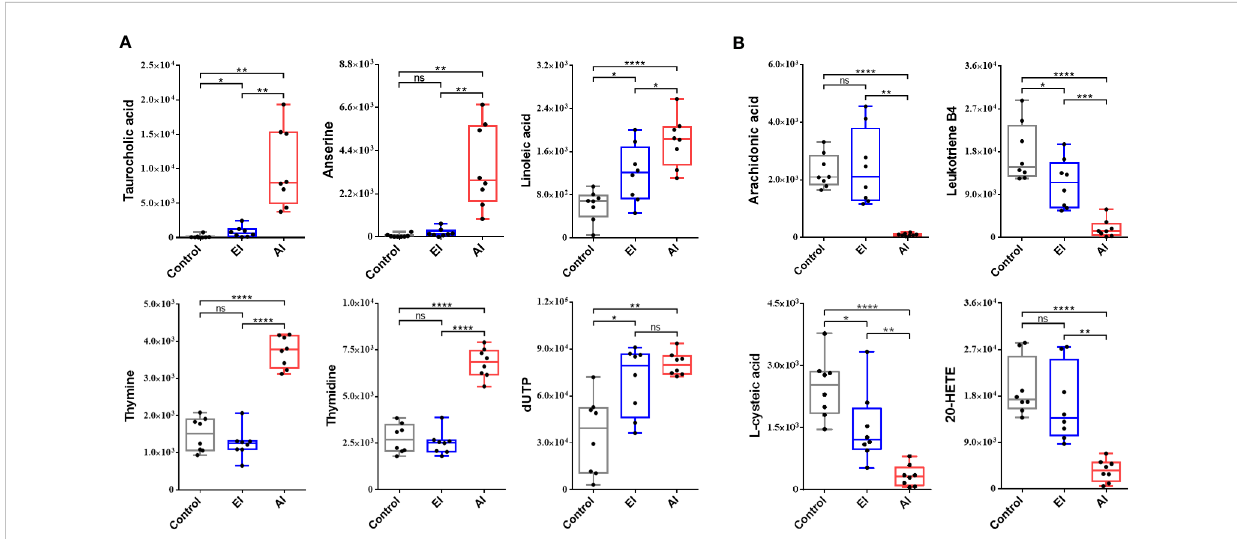
FIGURE 6 Box and whisker plots showing signi fi cantly perturbed metabolites correlated with the dysregulated metabolic pathways. (A) Top 6 upregulated metabolites in the enriched pathway. (B) Top 4 downregulated metabolites in the enriched pathway. EI, early infected group; AI, acutely infected group; Ctrl, noninfected group. Statistically signi fi cant differences in metabolites between groups were determined by t tests (*, p < 0.05; **, p < 0.01; ***, p < 0.001; ****, p <